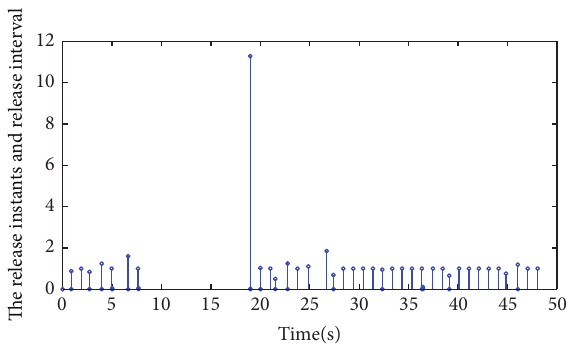
Figure 4: The release instants and release